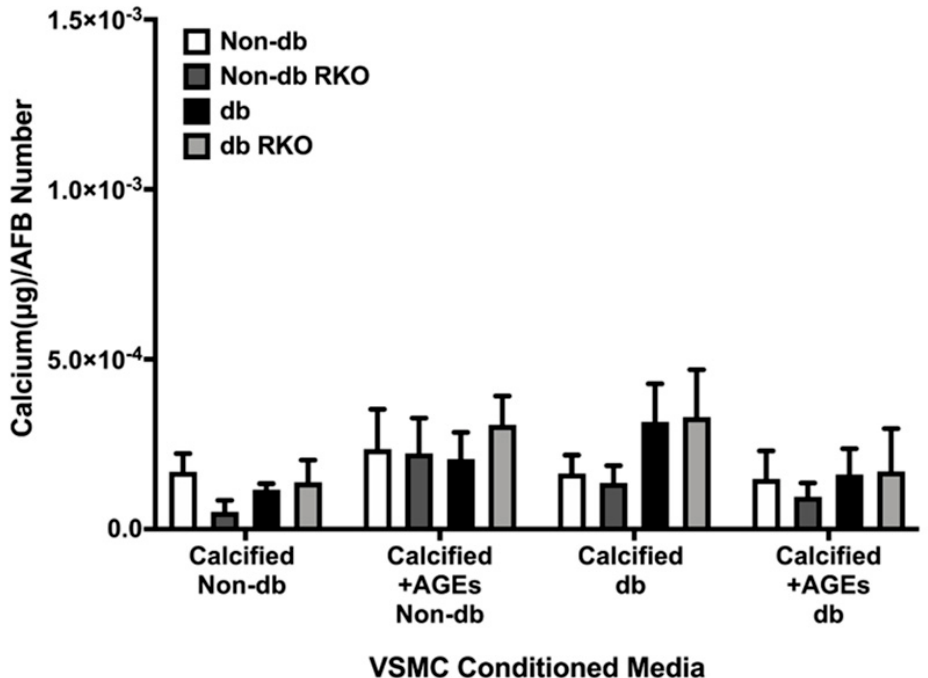
Figure 6. AFBs did not differentially respond to non-diabetic and diabetic VSMCs-conditioned media. Primary AFBs were isolated and treated with VSMCs-conditioned media at a dilution of 1:10 in 2% FBS genotype appropriate DMEM for 7 days. Calcium ( µ g) was normalized to the number of cells (DAPI) and graphs as mean ± SEM with n = 3–6 of independent replicates. Statistical analysis consisted of a two-way ANOVA ( p = 0.9727).